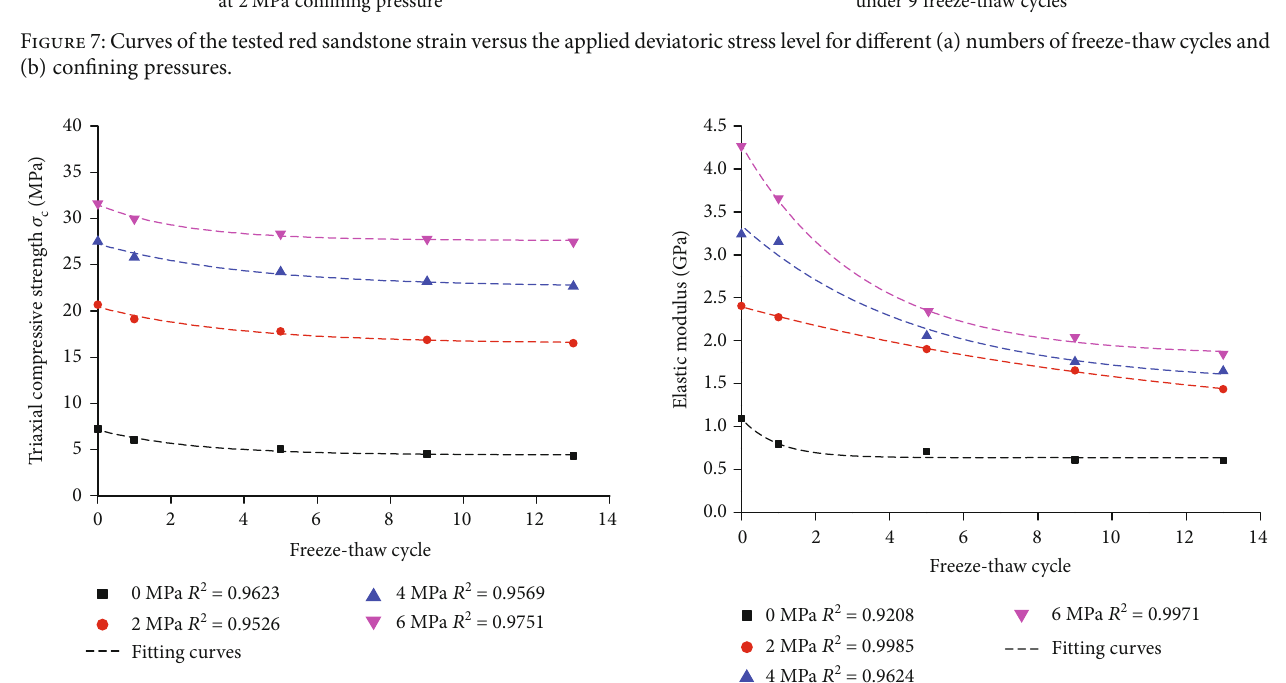
Figure 9: Curves of the elastic modulus of the tested red sandstone versus the number of freeze-thaw cycles under di ff erent con fi ning